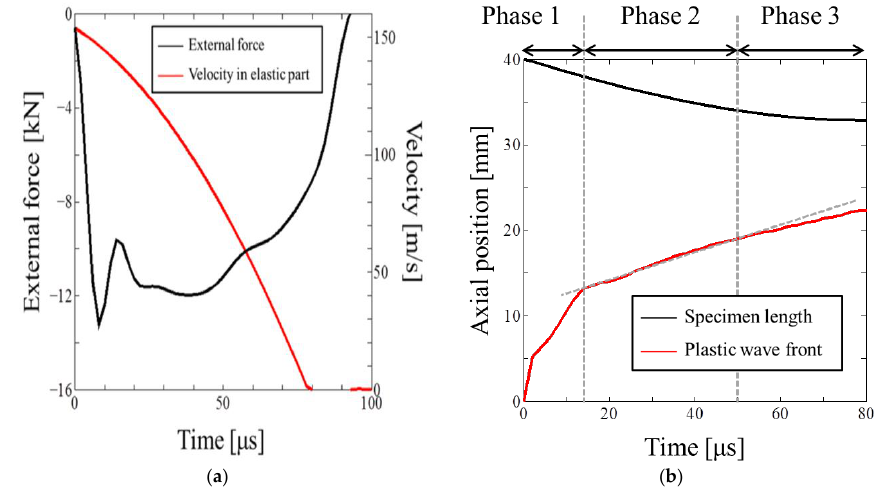
Figure 10. Time histories of some important parameters in the specimen. ( a ) External force and velocity in the elastic part. ( b ) Length and position of the plastic wave front.